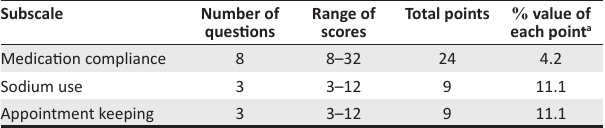
TABLE 1: Subscales within the Hill-Bone Compliance to High Blood Pressure Therapy Scale and calculation of % value per point.